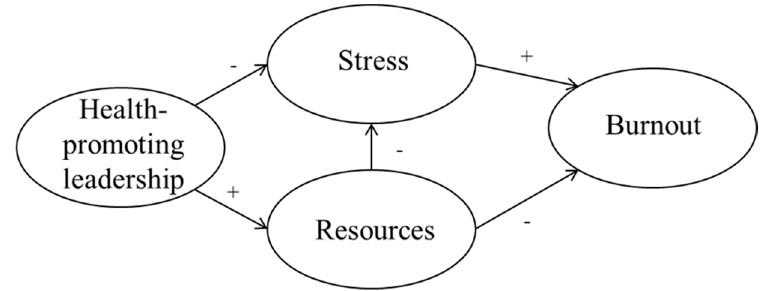
Figure 1. Hypothesized Model.